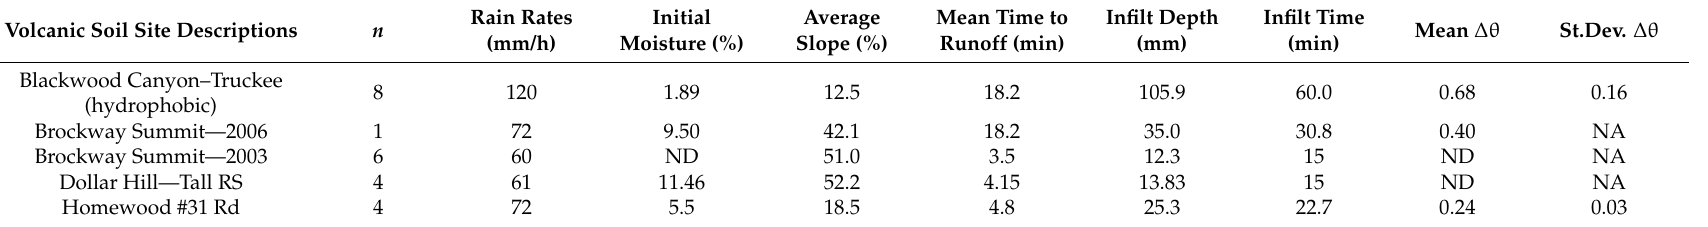
Table 6. Summary of RS plot setting data averages for volcanic soil plots generating